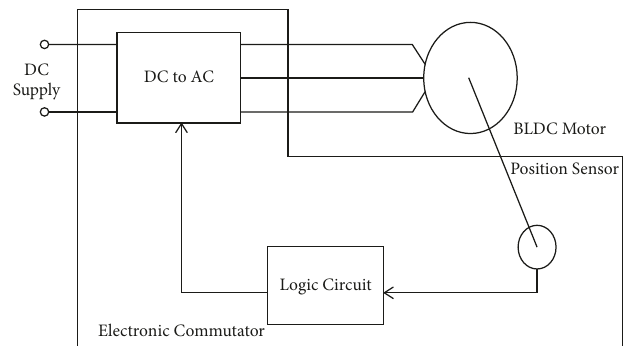
Figure 1: Constructional features of the BLDCM.